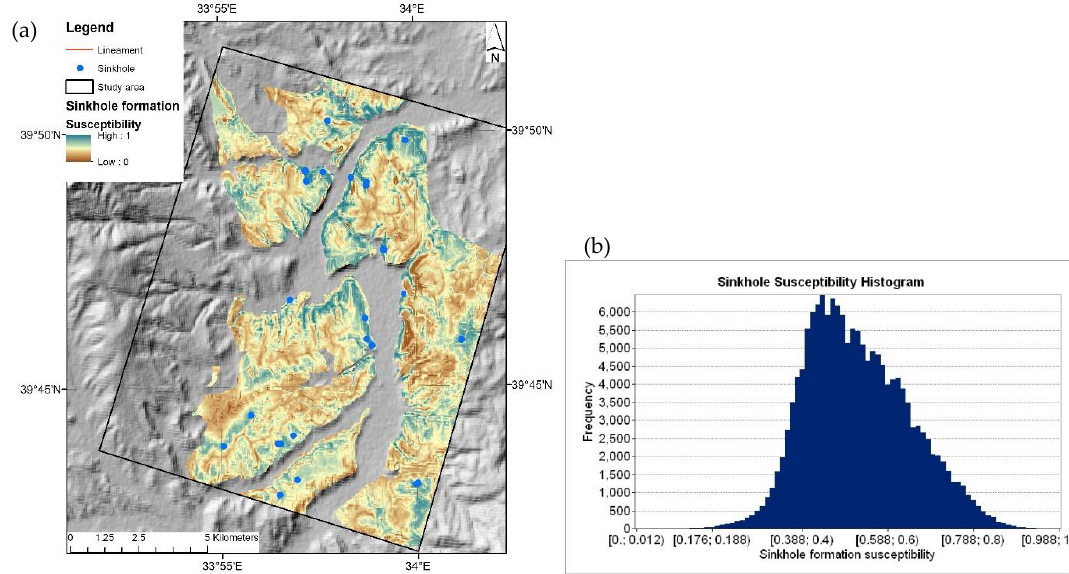
Figure 9. The resultant sinkhole susceptibility map of the study area ( a ), and the distribution of the sinkhole susceptibility values ( b ).